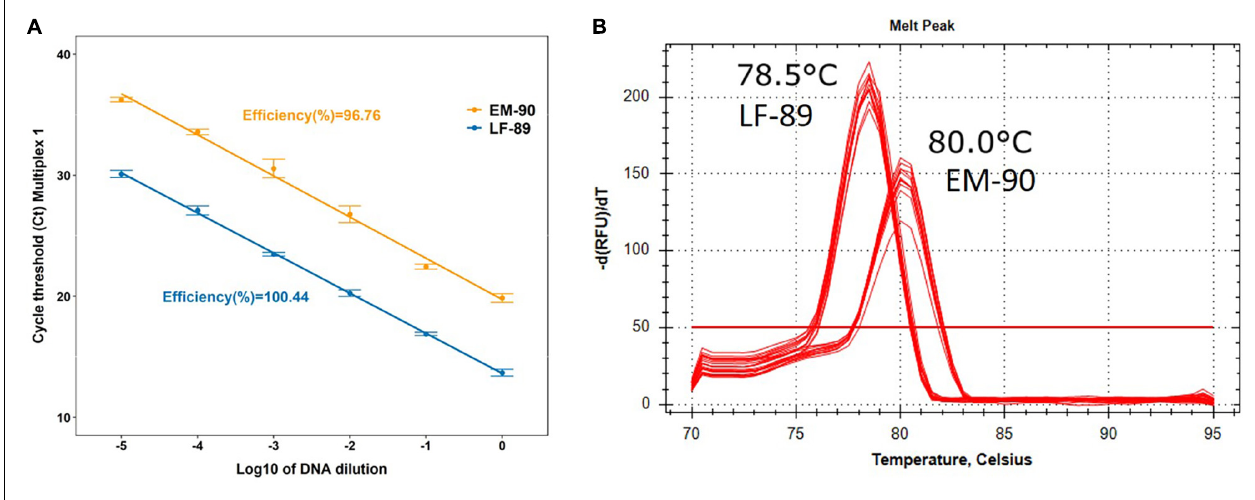
FIGURE 5 | Characterization of Multiplex-1 prototype using qPCR. (A) Standard curve and efficiency of reaction using LF-89 and EM-90-like isolates as DNA templates. (B) Melting temperature of the amplicon from LF-89 and EM-90-like